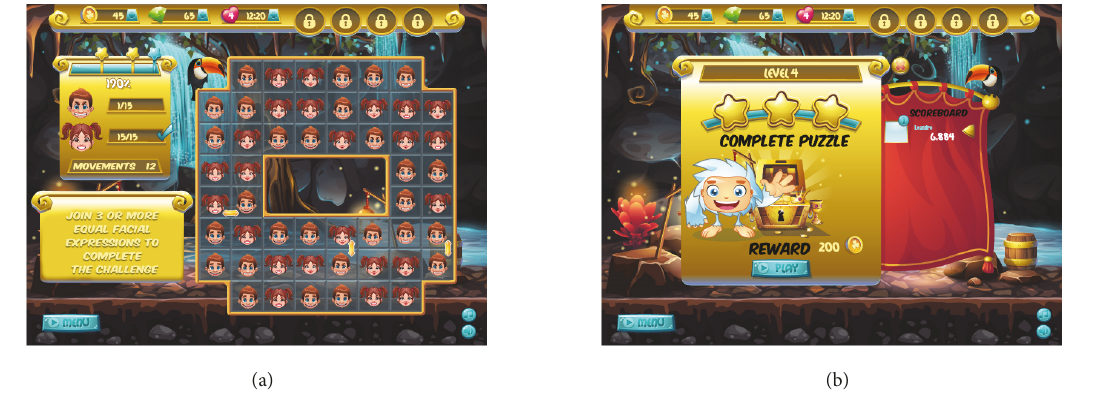
Figure 21: (a) Matching emotions [23]; (b) feedback interface.